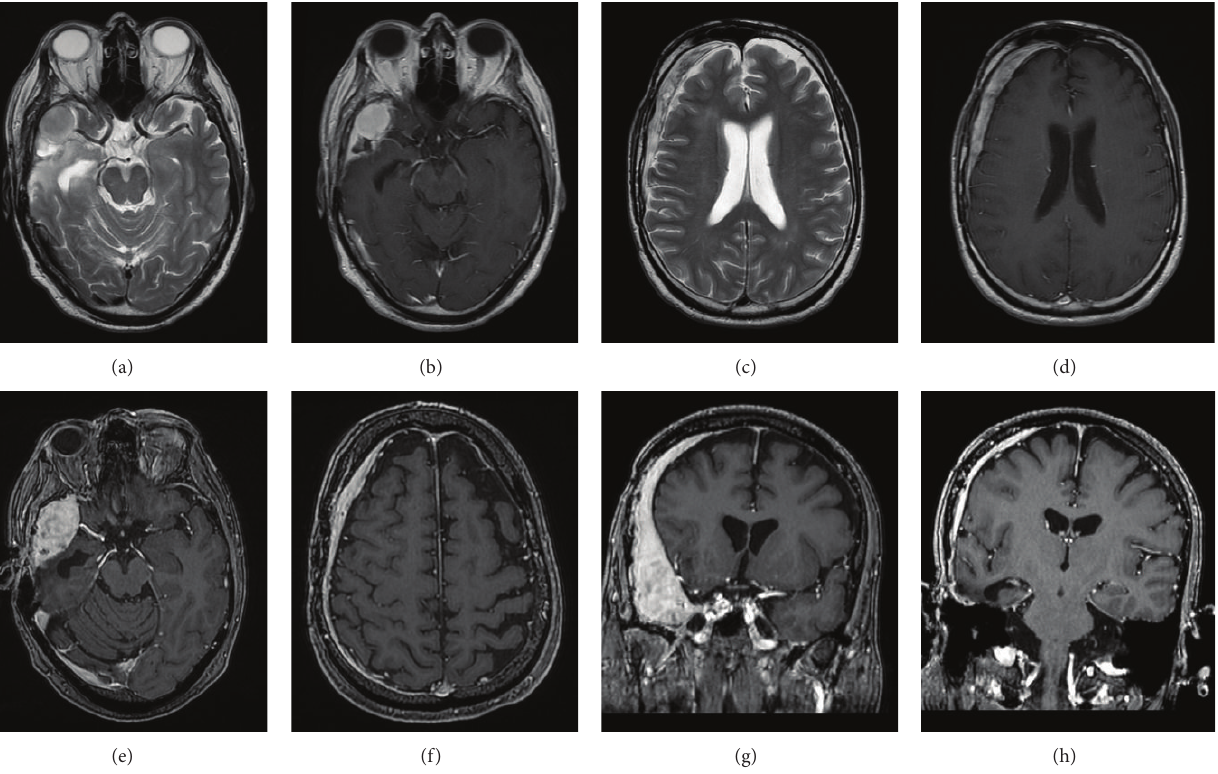
Figure 2: Appearance and progression of secondary tumor. T 2 -weighted ((a) and (c)) and gadolinium enhanced T 1 -weighted ((b) and (d)) images demonstrating the first appearance of the secondary tumor. ((e)–(h)) Gadolinium enhanced T 1 -weighted images showing progression of secondary